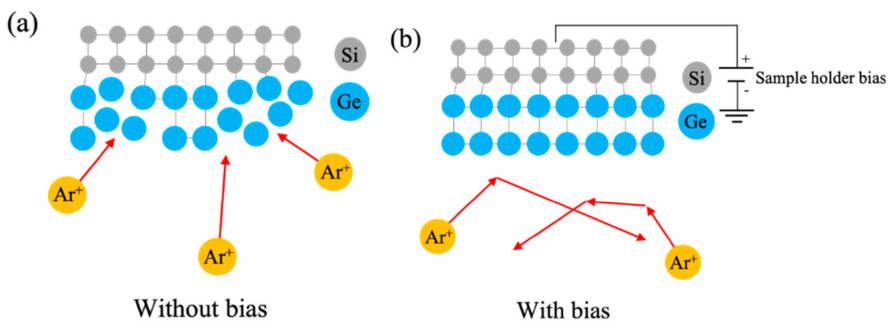
Figure 1. The effect of the bias voltage applied to the Ge films: ( a ) without bias; ( b ) with positive bias. The sputtering power during RF magnetron sputtering was then adjusted to 75, 100 and 125 W. Figure 2a shows an X-ray diffraction (XRD) measurement of the 75 W sputtering power Ge film with a wide scanning range, with 2 θ from 20 ◦ to 80 ◦ . There are only two XRD peaks in this measurement, which belong to the (004) planes of the Ge film (65 ◦ to 66 ◦ ) and Si substrate (69.1 ◦ ) [17]. From this result, it is determined that the Ge thin film is